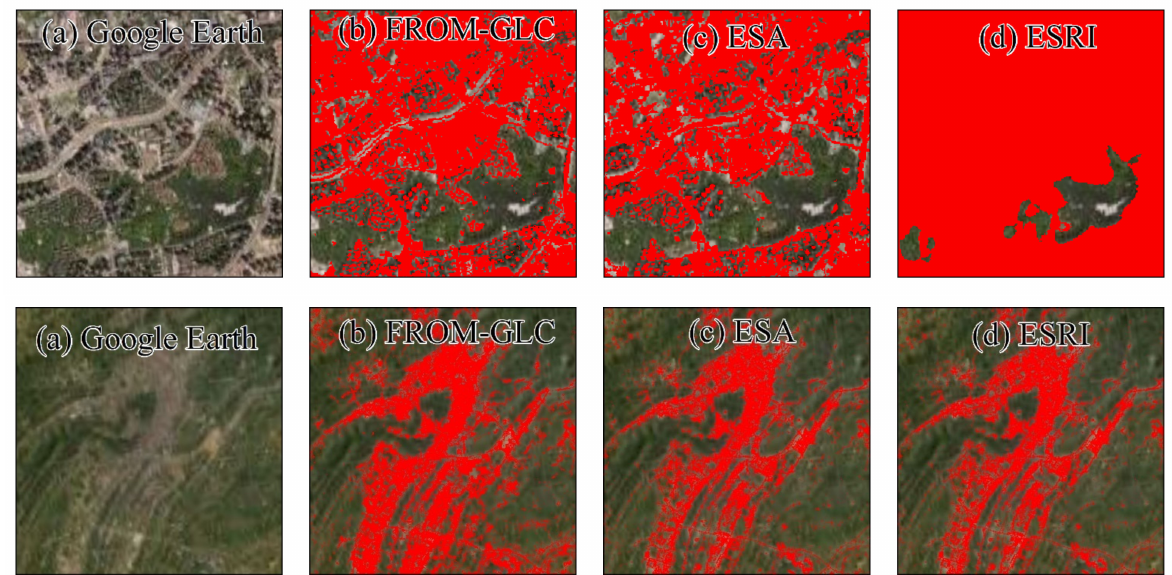
Figure 10. Visual comparison of built-up type with Google Earth image (red is built-up): ( a ) Google Earth, ( b ) FROM-GLC, ( c ) ESA, ( d )